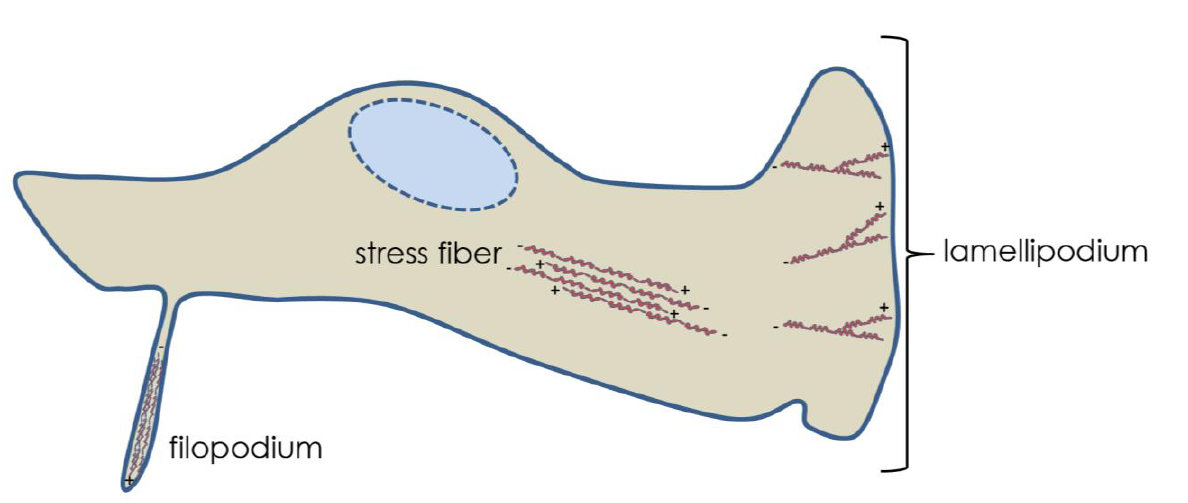
Figure 1. Examples of Actin Networks. Filopodium, stress fiber, and lamellipodium structures are featured showing actin